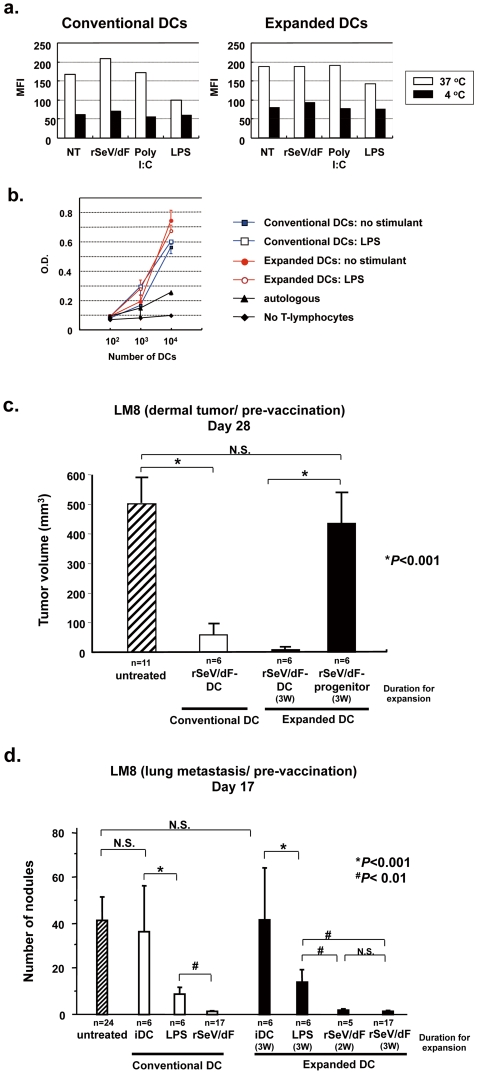
Assessment of functions that are typically seen in DCs.a. FITC-dextran uptake assay assessing endo-/phagocytotic activity, a typical feature of antigen-presenting cells such as DCs. This experiment was performed in triplicate, and showed similar results. b. A graph showing MLR activity for allo-antigen (C57BL6) by iDCs or activated DCs (C3H/He) by LPS derived from the conventional technique or expansion of HPs. c. Antitumor effect of subcutaneous vaccination with rSeV/dF-activated DCs that were derived from conventional or expansion techniques. Female C3H/He mice (7-week-old) were subcutaneously vaccinated via the left flank three times each weeks with 1×106 conventional/expanded DCs pulsed with tumor lysate. Two days after the final vaccination, 1×106 LM8 cells were inoculated intradermally into the left flank of mice. Note that 3-weeks expanded HPs treated with rSeV/dF did not show any effect on tumor growth. d. Antimetastatic activity via bolus intravenous injection of various DCs. Female C3H/He mice (7-week-old) were intravenously vaccinated with 1×106 conventional/expanded DCs once via the tail vein, and 2 days later, 1×106 of LM8 cells were inoculated intravenously. Seventeen days later, mice were sacrificed and the macroscopically recognized nodules on the surface of the bilateral lungs were counted.